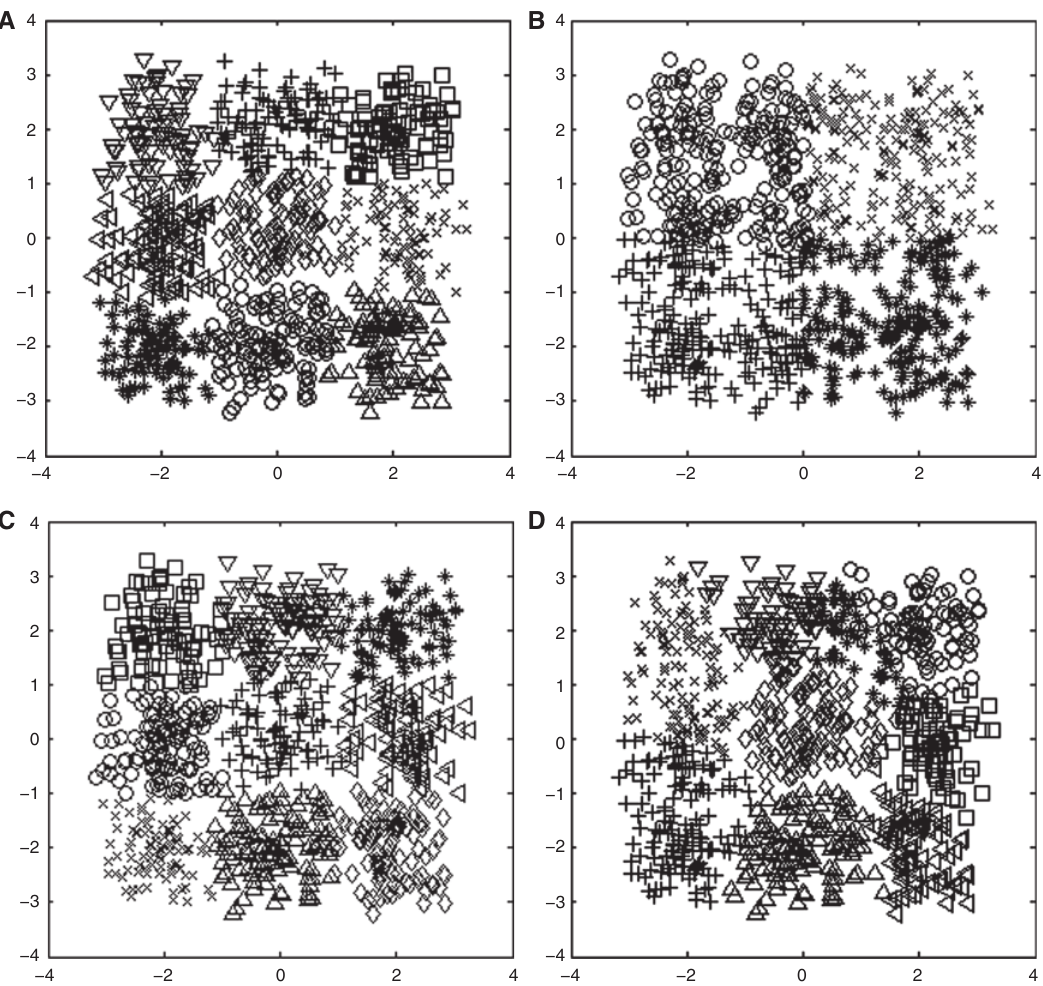
Figure 7: (A) Clustered Mixed_9_2 after the Application of KM for K = 9. (B) Clustered Mixed_9_2 after the Application of FCM for K = 4. (C) Clustered Mixed_9_2 after the Application of FCM for K = 9. (D) Clustered Mixed_9_2 after the Application of MHSC for K = 9. Table 5: Minkowski Scores Obtained by Three Clustering Algorithms for Real-Life Datasets.